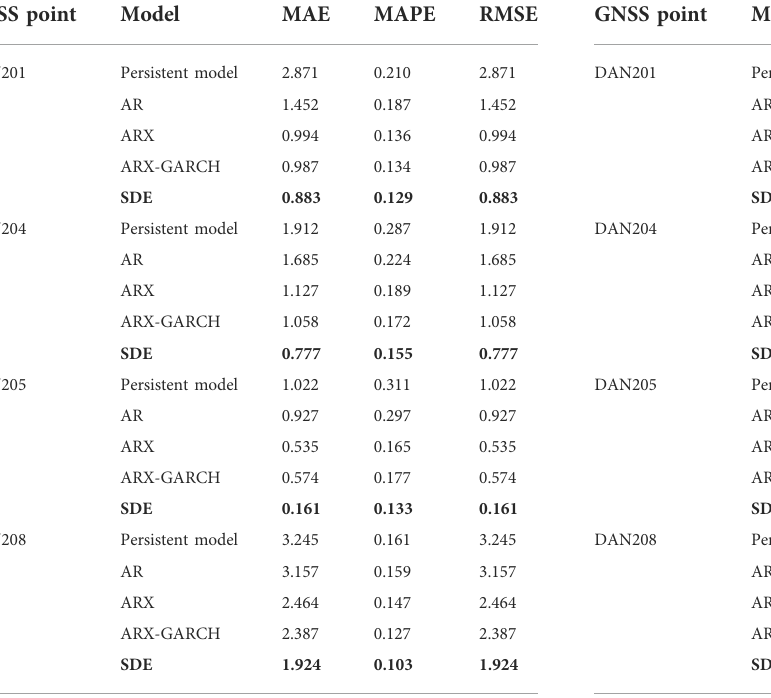
Bold font indicates best results.